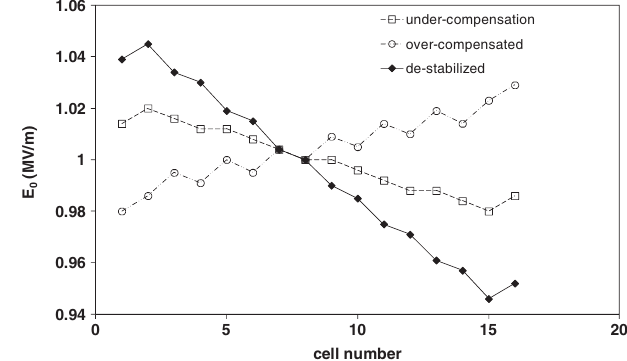
FIG. 18. The PC effect in a perturbed field with gap PC-DT at 3 different configurations described above.